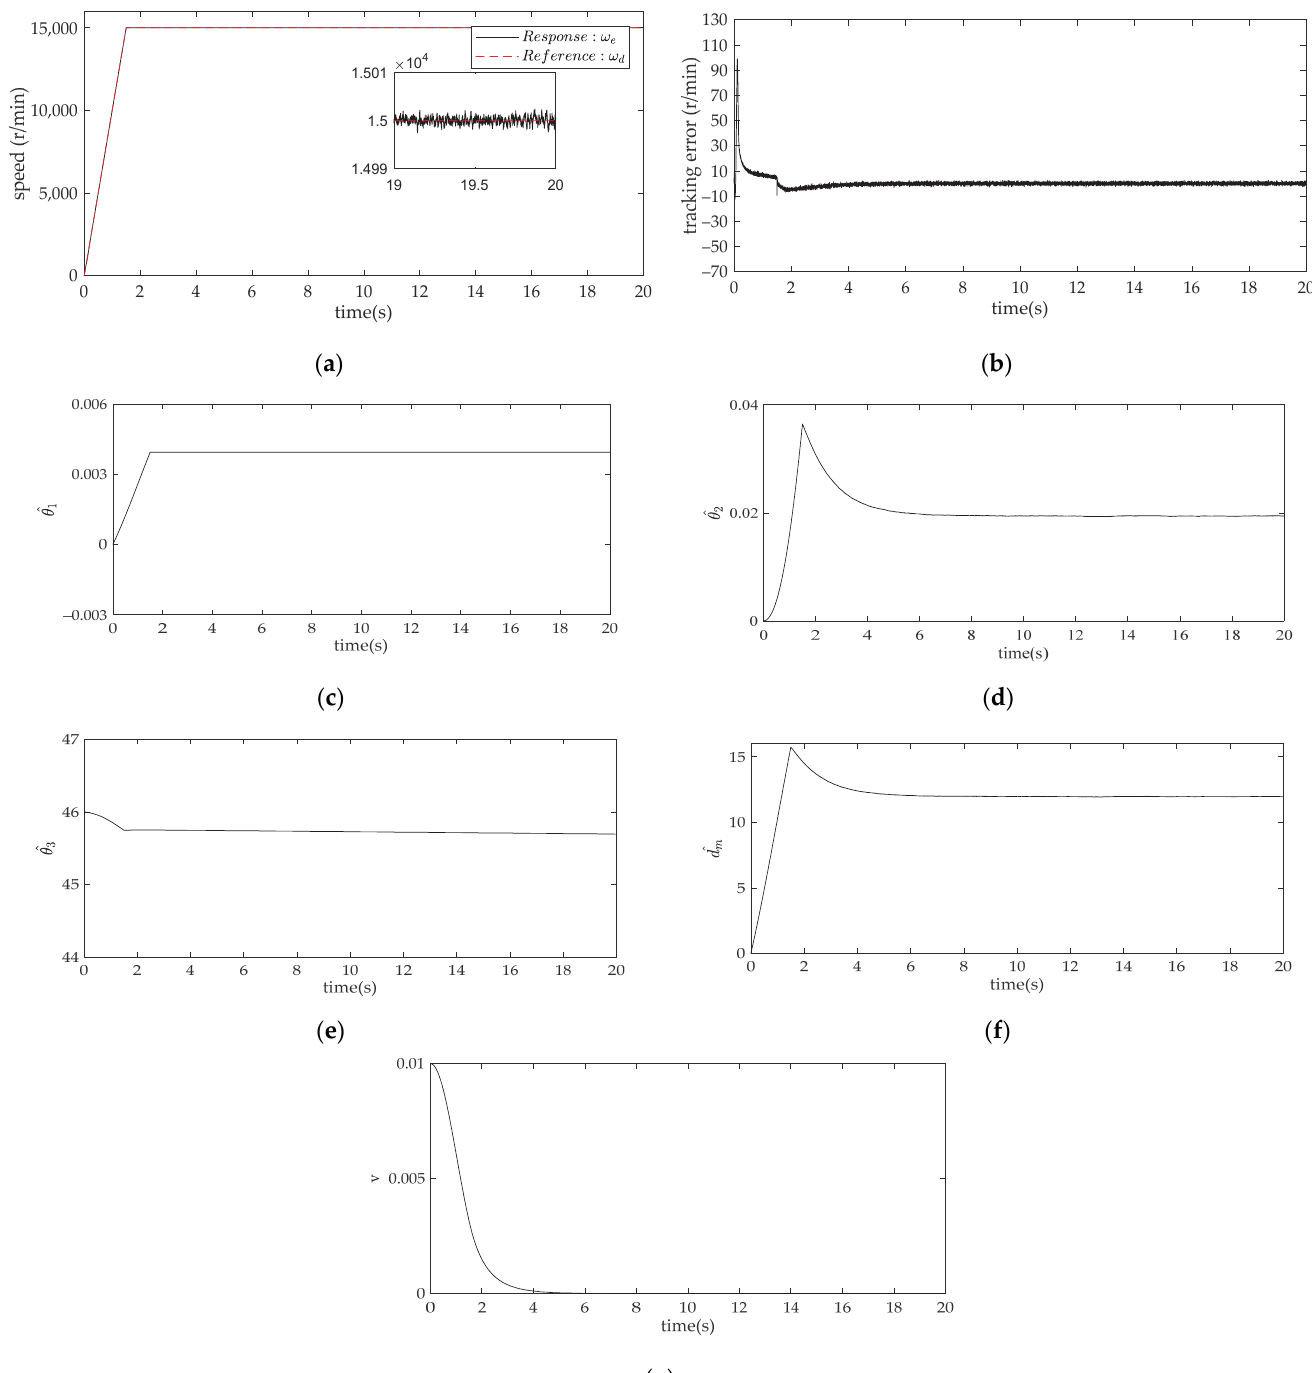
Figure 7. ( a ) Speed response under PID control; ( b ) Tracking error of PID.